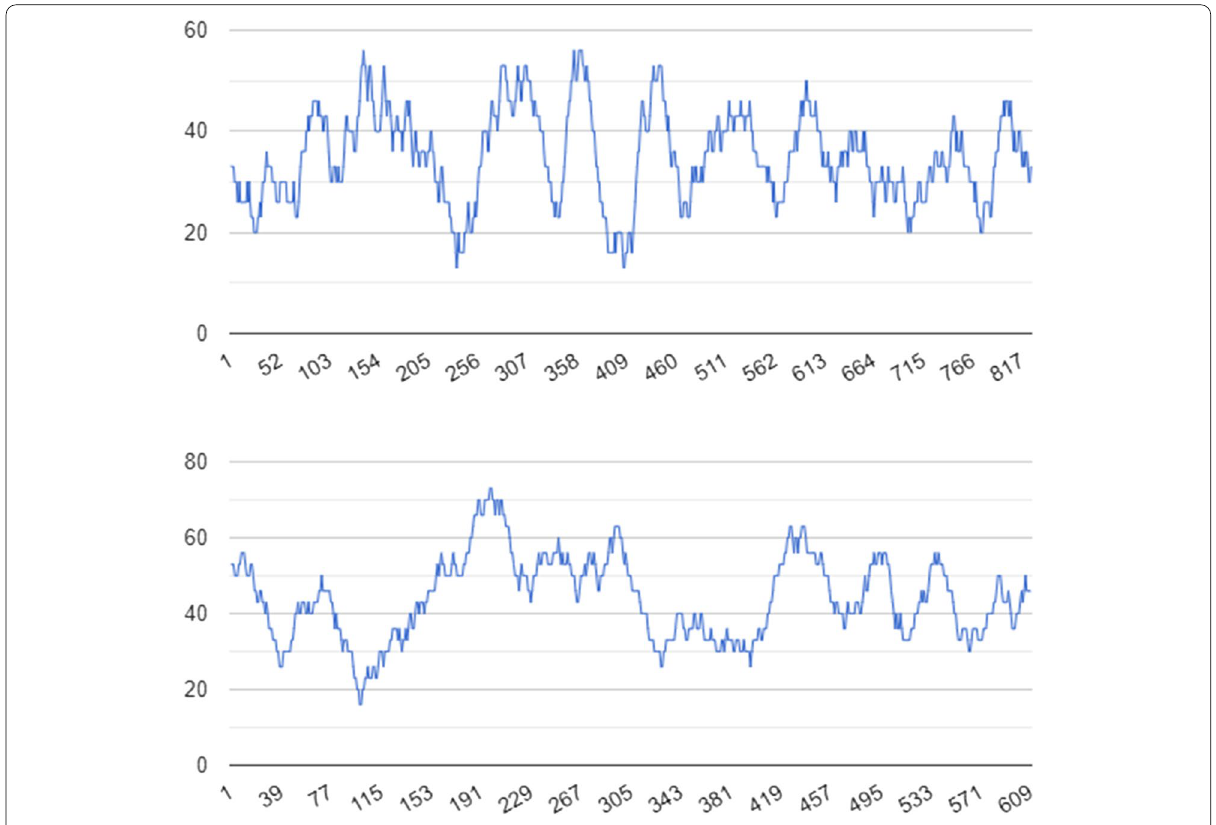
Fig. 4 GC content distribution of matK (upper panel) and rbcL (lower panel) in sequences gene